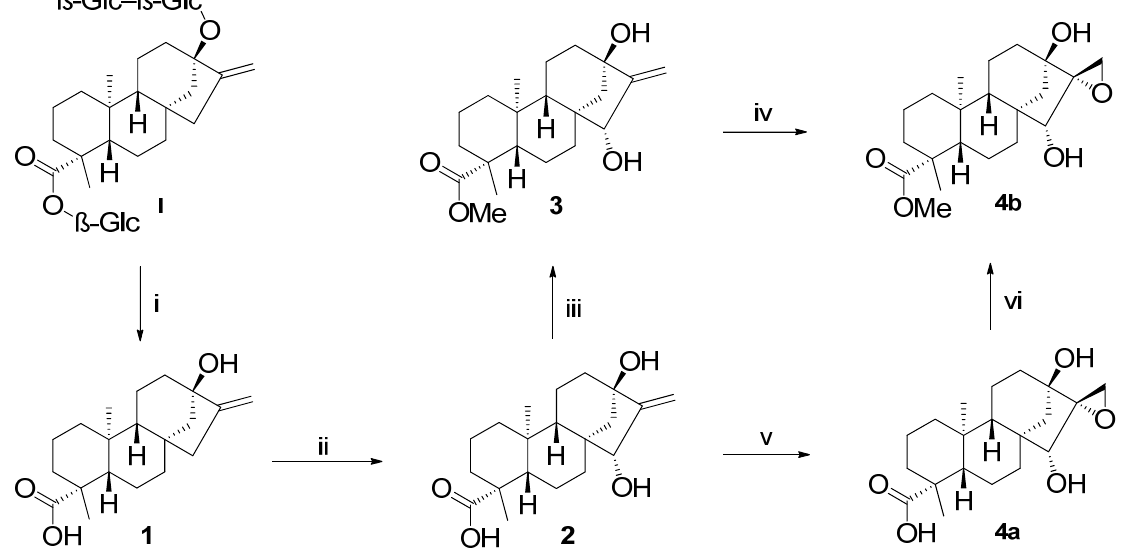
Scheme 1. Chemo- and stereoselective synthesis of key intermediate spiro-epoxide 4b from